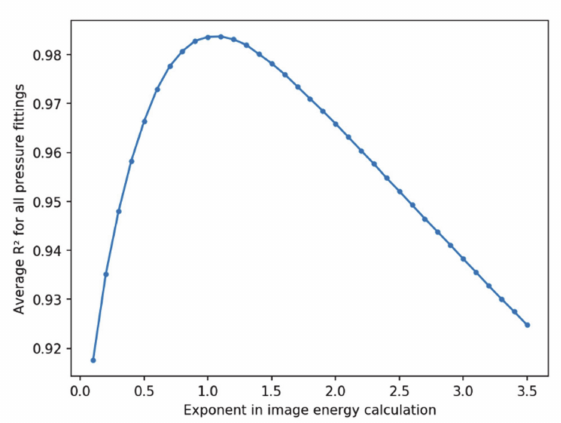
Figure 8. Detail of how the quality of the linear fitting between electrical power and image energy varies as a function of the chosen exponent k in (3) for image energy calculation ranging from 0.1 to 3.5.